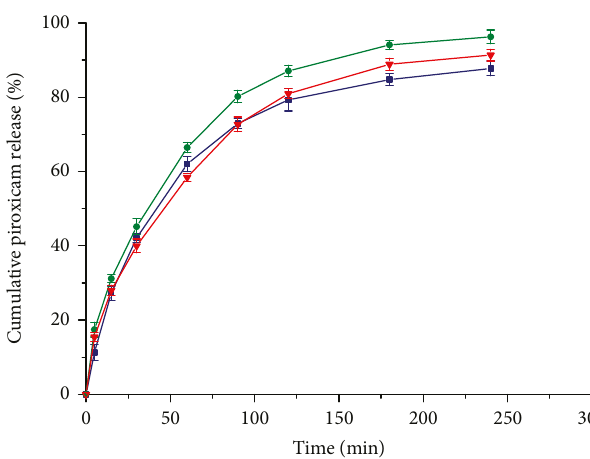
Figure 4: Cumulative release pro fi les of piroxicam from collagen matrices versus time: 1% piroxicam (blue square), 1.5% piroxicam (green circle), and 2% piroxicam (red triangle) ( n = 3